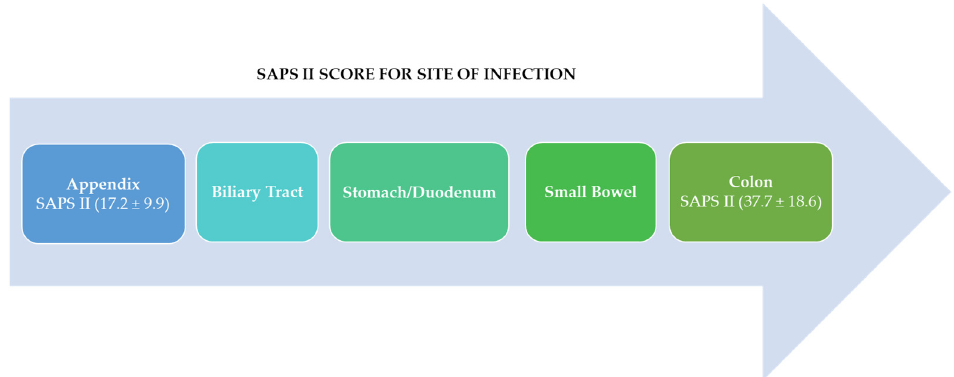
Figure 3. This arrow diagram represents SAPS II from higher values to lower values. The SAPS II